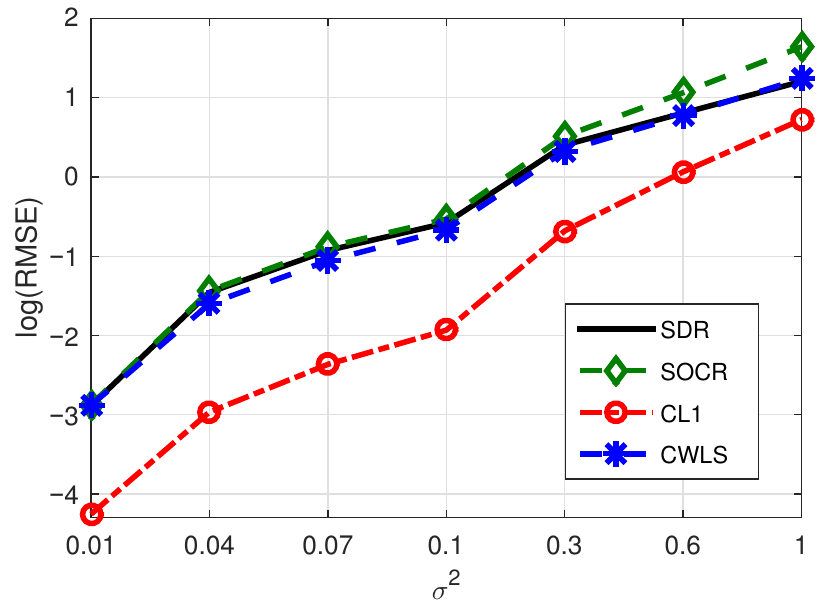
Figure 2. RMSE comparison of four methods under the conditions of six BSs and one NLOS.